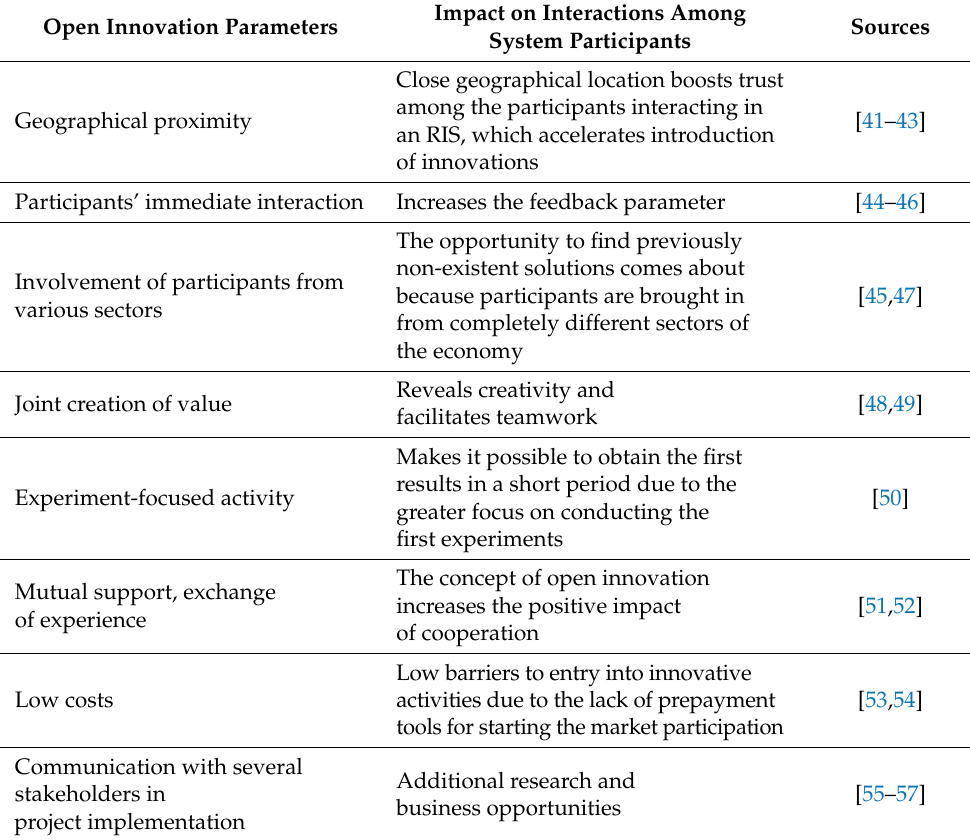
Table 1. Open innovation parameters and their relationship to RISs.